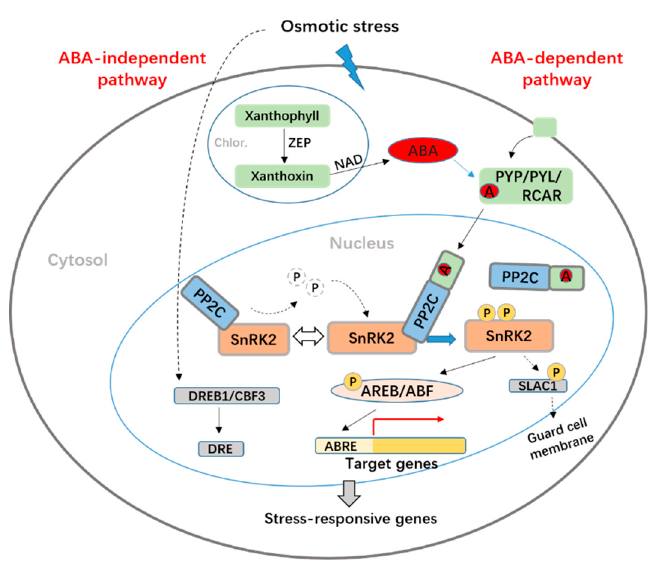
Figure 8. Possible molecular mechanisms involved in drought response in potato P3-198.